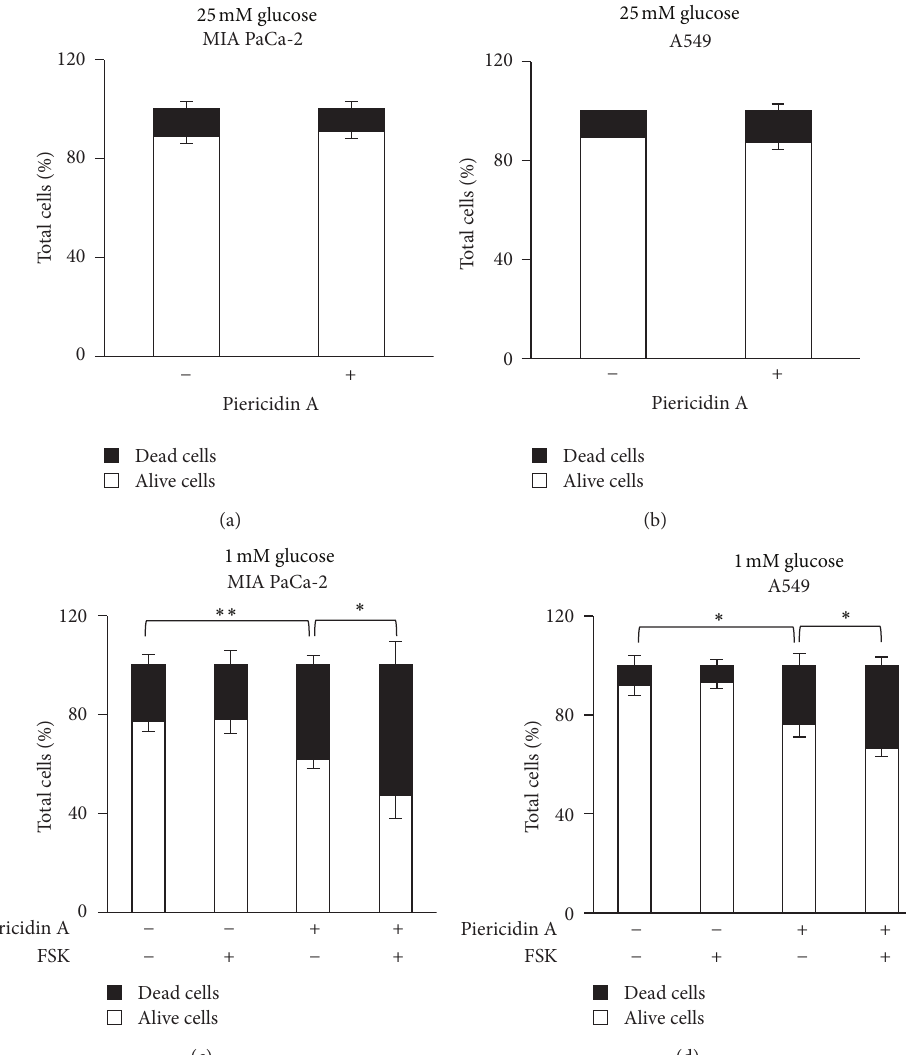
Figure 6: Piericidin A and low glucose synergize in inducing death also of pancreatic and lung cancer cells. Viable cell count using Trypan Blue was performed after treatment with 10nM piericidin A in different growth conditions. (a)-(b) MIA PaCa-2 (pancreatic, A) and A549 (lung, B) cancer cells were cultured in 25 mM glucose and counted after 8-hour treatment. (c)-(d) MIA PaCa-2 (c) and A549 (d) cells were cultured in 1mM glucose and treated with piericidin A, 10 𝜇 M FSK, or FSK plus piericidin A. For the cotreatment experiments, cells were pretreated with FSK for 1 hour and then piericidin A was added for 8 hours (see Figure 2(c), as example). After treatment cell count was performed. All data represent the average of at least three independent experiments ( ± s.d.); ∗ 𝑃 < 0.05 , ∗∗ 𝑃 < 0.01 (Student’s 𝑡